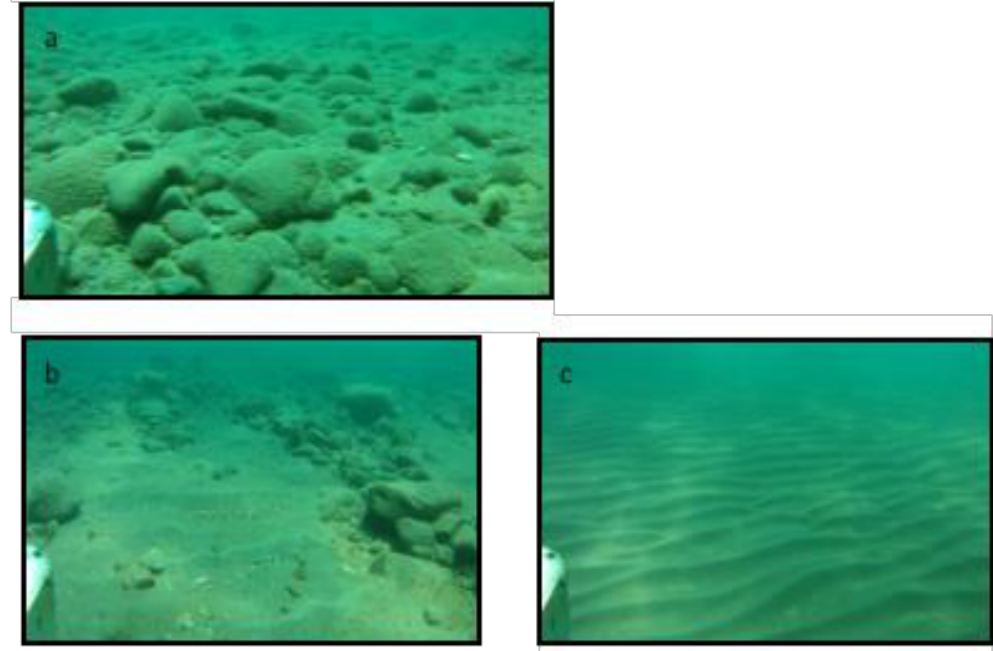
Figure 11. ROV-mounted camera views of Bu ff alo Reef boulder / cobble fields: Most of the cobbles are rounded glacial erratics ( a , top), lying on top of, rather than originating from, the Jacobsville Sandstone bedrock. During spawning, fish eggs drop into the crevices between rocks. Stamp sands moving into the northern cobble field of Bu ff alo Reef ( b , bottom left), burying cobbles and killing periphyton communities on rocks along the leading edge. Ripples in the migrating stamp sands ( c , bottom right), as stamp sands move out of the “trough.”.